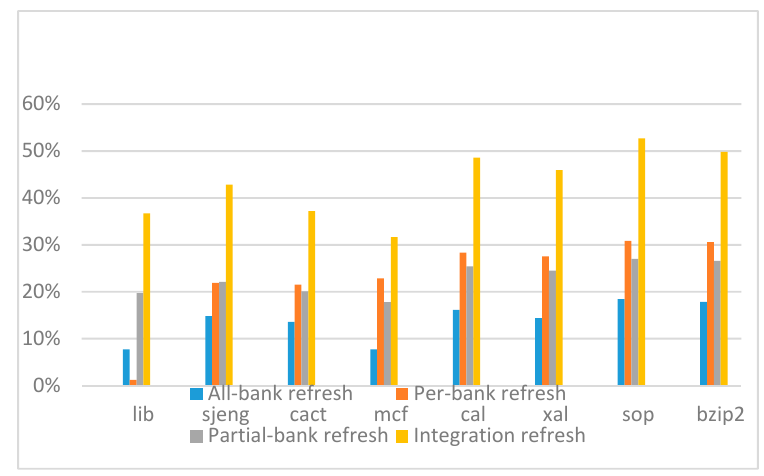
Figure 22. Energy reduction normalized to 1x granularity baseline (tRFC = 530 ns, weak row = 1%).